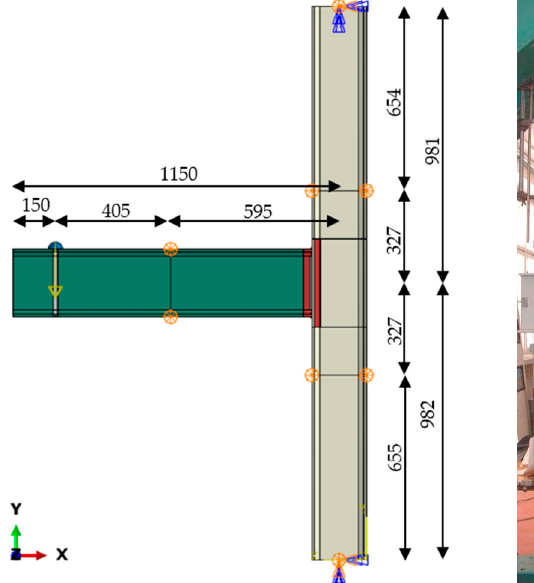
Figure 6. Welded beam-to-column joint set-up: ( a ) Numerical model (axial dimensions, units in mm); ( b ) Experimental set-up [27]